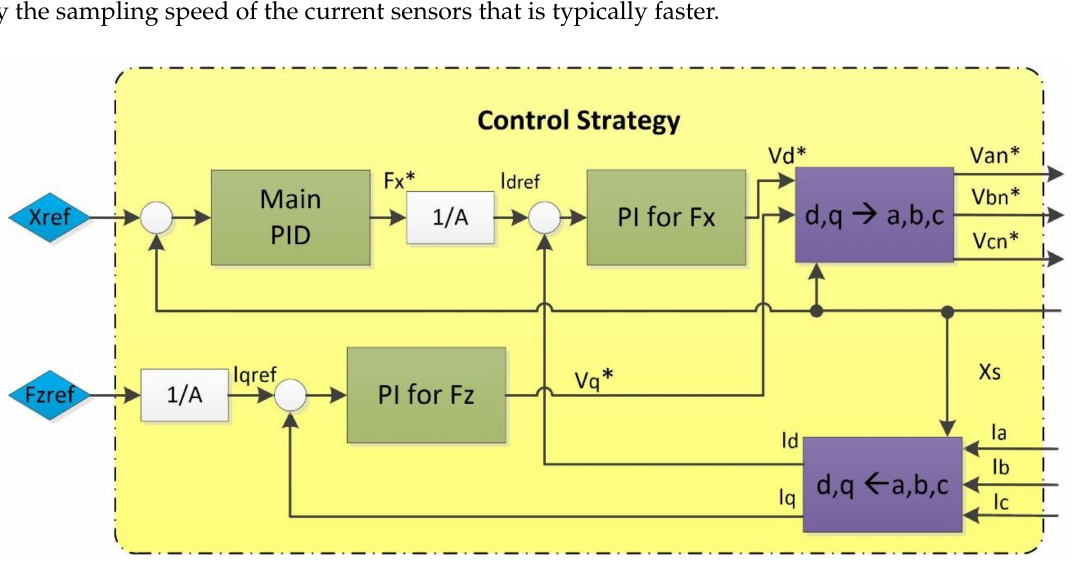
Figure 5. Vector control strategy for linear